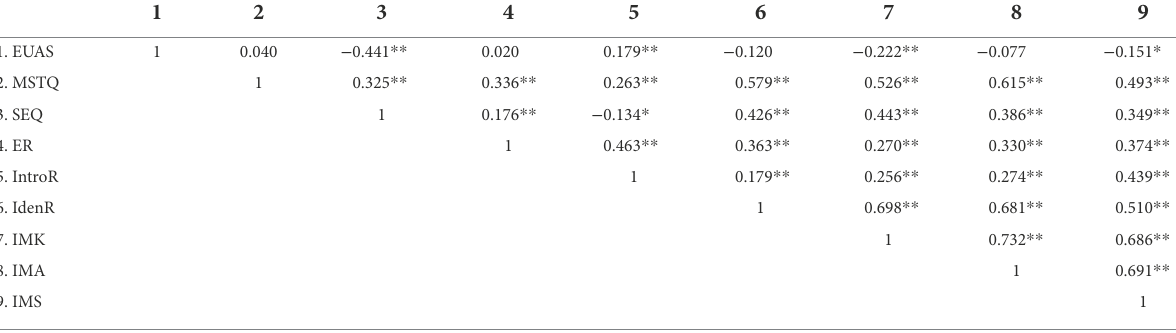
TABLE 3 Correlations among English use anxiety, motivation, and self-efficacy.